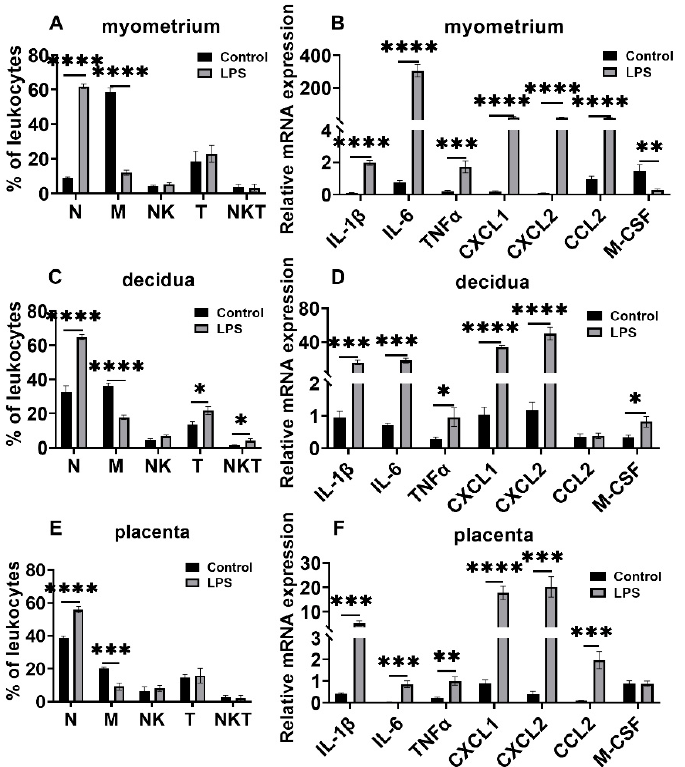
Figure 5. Changes in leukocyte subsets as well as cytokine and chemokine expression in gestational tissues at preterm labor induced by LPS. Pregnant mice were administered LPS or vehicle at GD16.25. The mice with LPS were sacrificed after the onset of labor. The control mice were sacrificed at the corresponding time of the LPS group. Myometrium, decidua, and placenta were obtained for determination of the populations of neutrophils, macrophages, NK, T cells, and NKT cells by flow cytometry analysis and the chemokine and cytokine expression by Q-PCR. ( A , B ) Leukocyte subsets and cytokine and chemokine mRNA levels in myometrium; ( C , D ) leukocyte subsets and cytokine and chemokine mRNA levels in decidua; ( E , F ) leukocyte subsets and cytokine and chemokine mRNA levels in placenta. Data are expressed as mean ± SEM. n = 6 in each group. * p < 0.05, ** p < 0.01, *** p < 0.001, **** p < 0.0001. N, neutrophils; M,